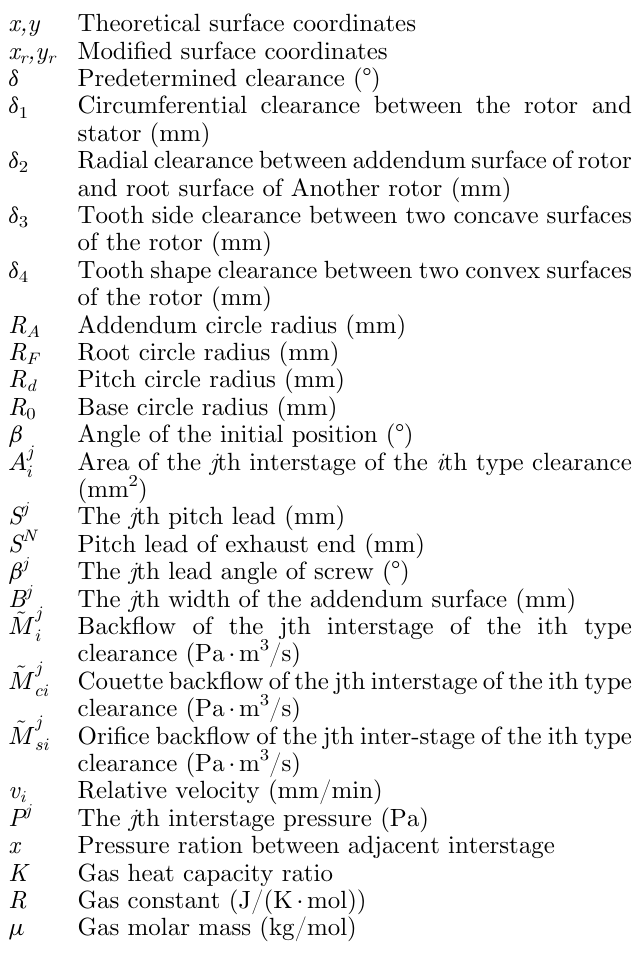
Fig. 23. Comparisons of three methods of the 1st interstage total back fl ow in